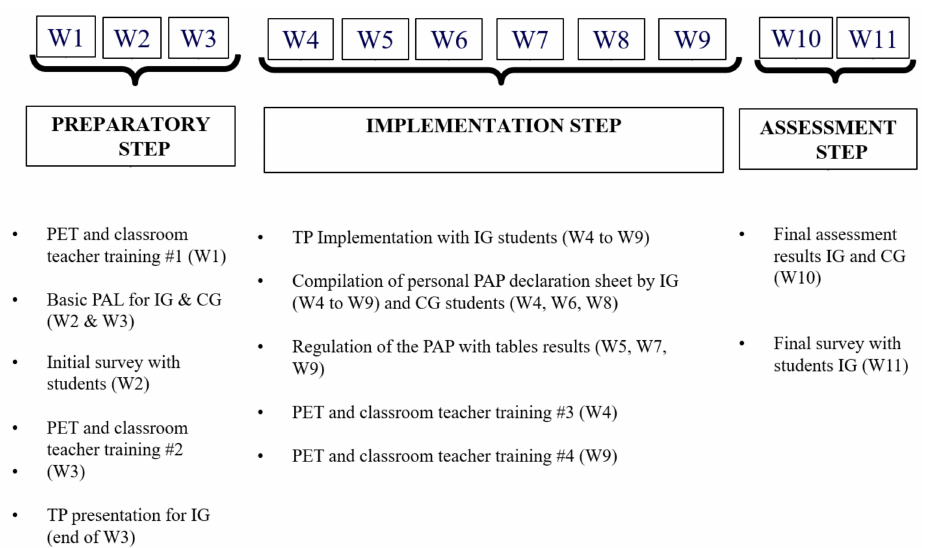
Figure 1. Schedule and Steps of the Study. Legends: W (Week), CG (Control Group), IG (Evaluated